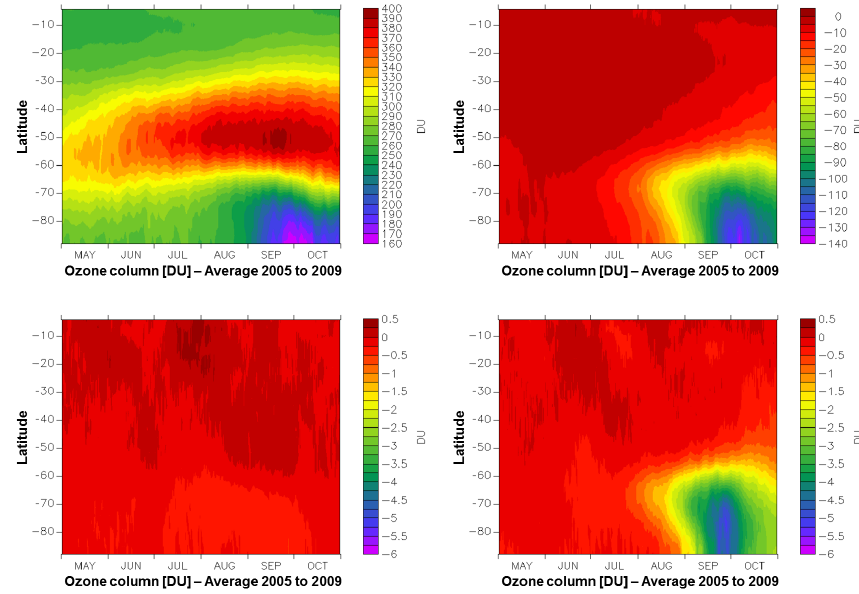
Figure 7. Ozone columns – development of ozone column in DU in the standard simulation during Antarctic winter and spring in the Southern Hemisphere averaged over the years 2005 to 2009 (top left) and contribution of liquid particles (top right), additional NAT particles (bottom left) and additional ice particles (bottom right) to ozone depletion. Note that the colour bars have different